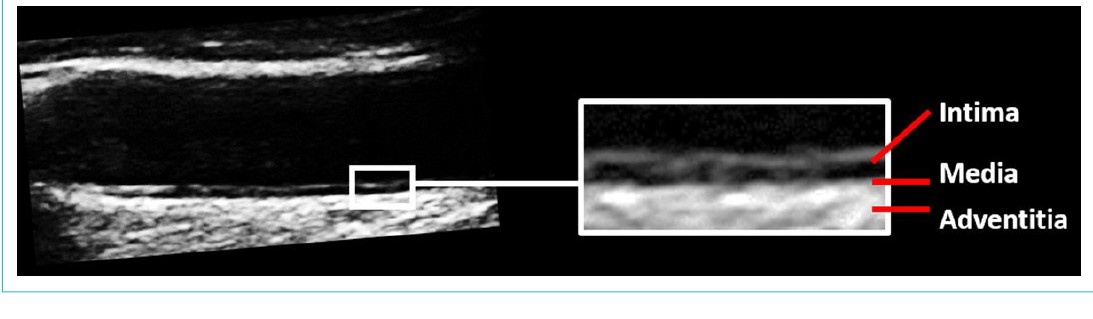
Figure 2: Anatomy of the carotid artery wall. The image represents the far wall of the common carotid artery showing the intima and media, defined by the distance between the endothelium and the external elastic membrane. For clinical purposes, the distance between the endothe- lium and the tunica adventitia is measured to obtain the intima-media thickness (IMT).